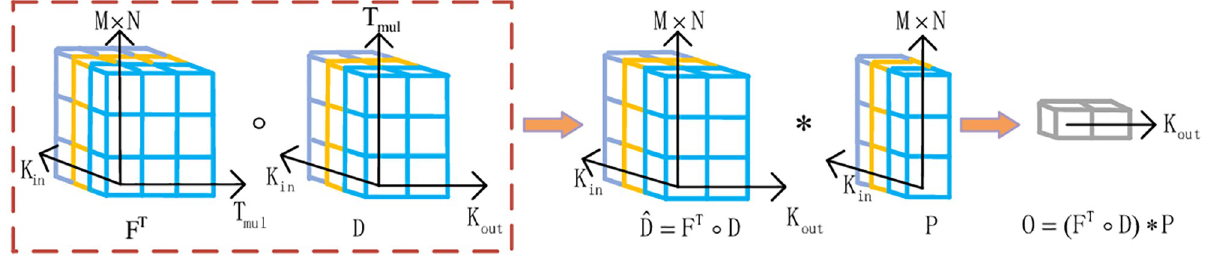
Fig 1. Illustration of DO-Conv. The deep convolution and conventional convolution kernel are included in DO-Conv. � means the depthwise convolution operator and � means convolution operator.